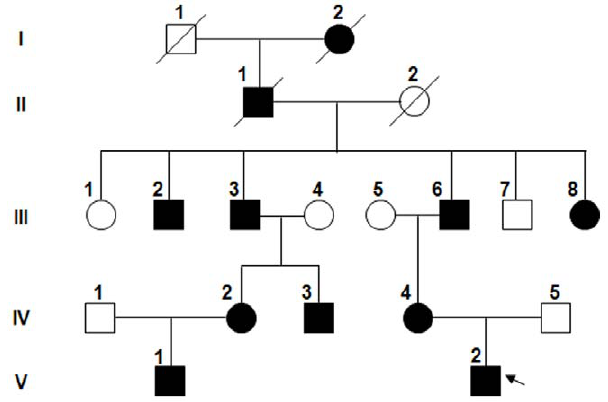
Figure 1. Pedigree of the family with bleeding disorder. Squares and circles indicate males and females, respectively, and arrow indicates the proband. Black color denotes affected individuals. A slash through the symbol indicates decreased individuals.